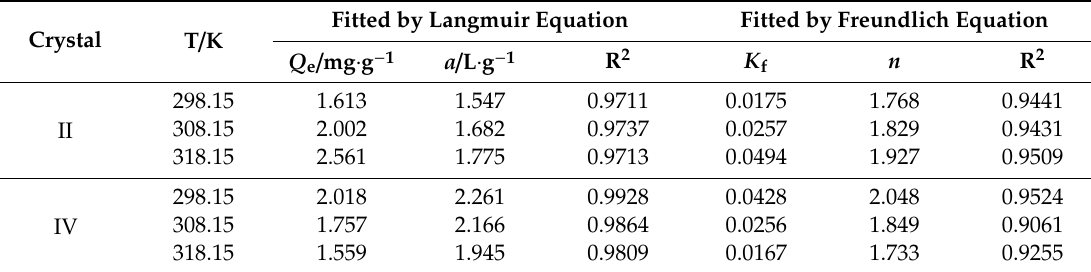
Table 2. Fitting parameters of Langmuir and Freundlich adsorption isotherm for dispersant 2700 onto pyraclostrobin crystal forms II and IV at di ff erent